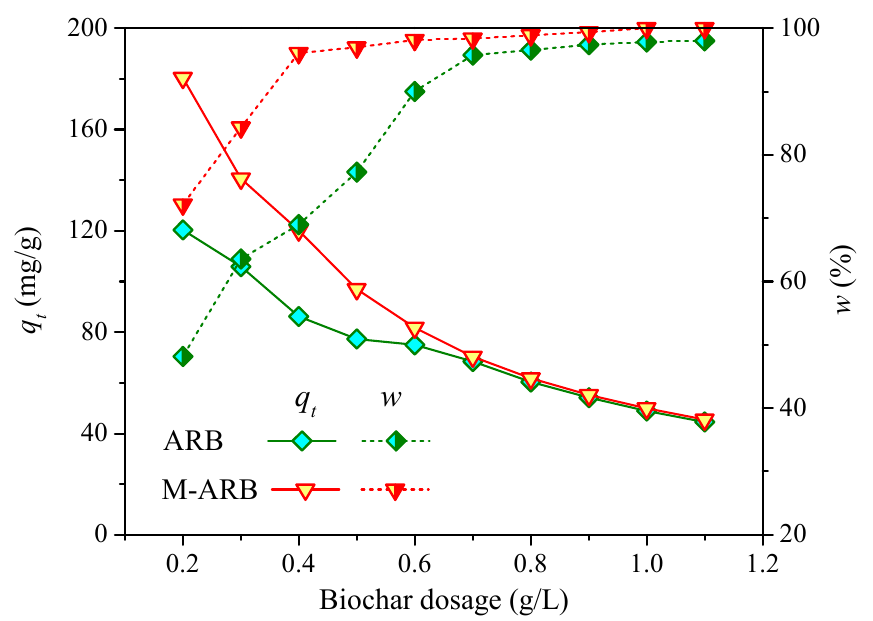
Figure 4. Effect of biochar dosage on MB adsorption performance.